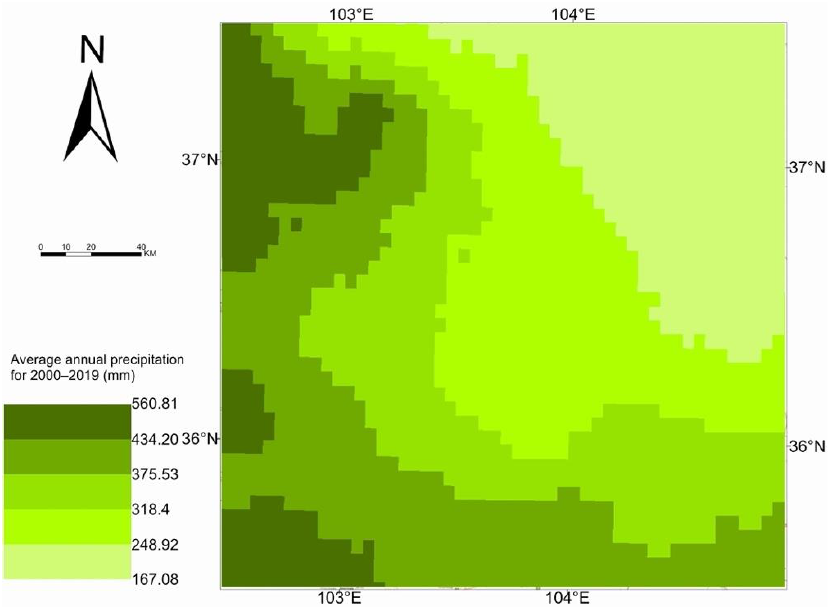
Figure 2. Spatial pattern of the annual precipitation in the study area. The spatial pattern of vegetation greenness generally agrees with the spatial pattern of precipitation.